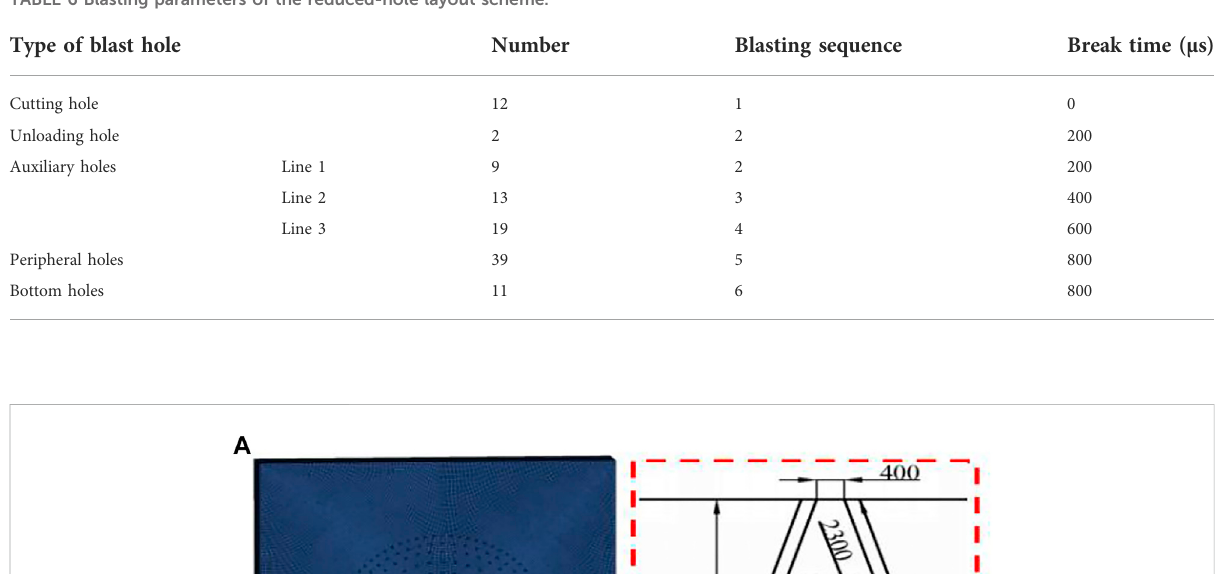
TABLE 6 Blasting parameters of the reduced-hole layout scheme.